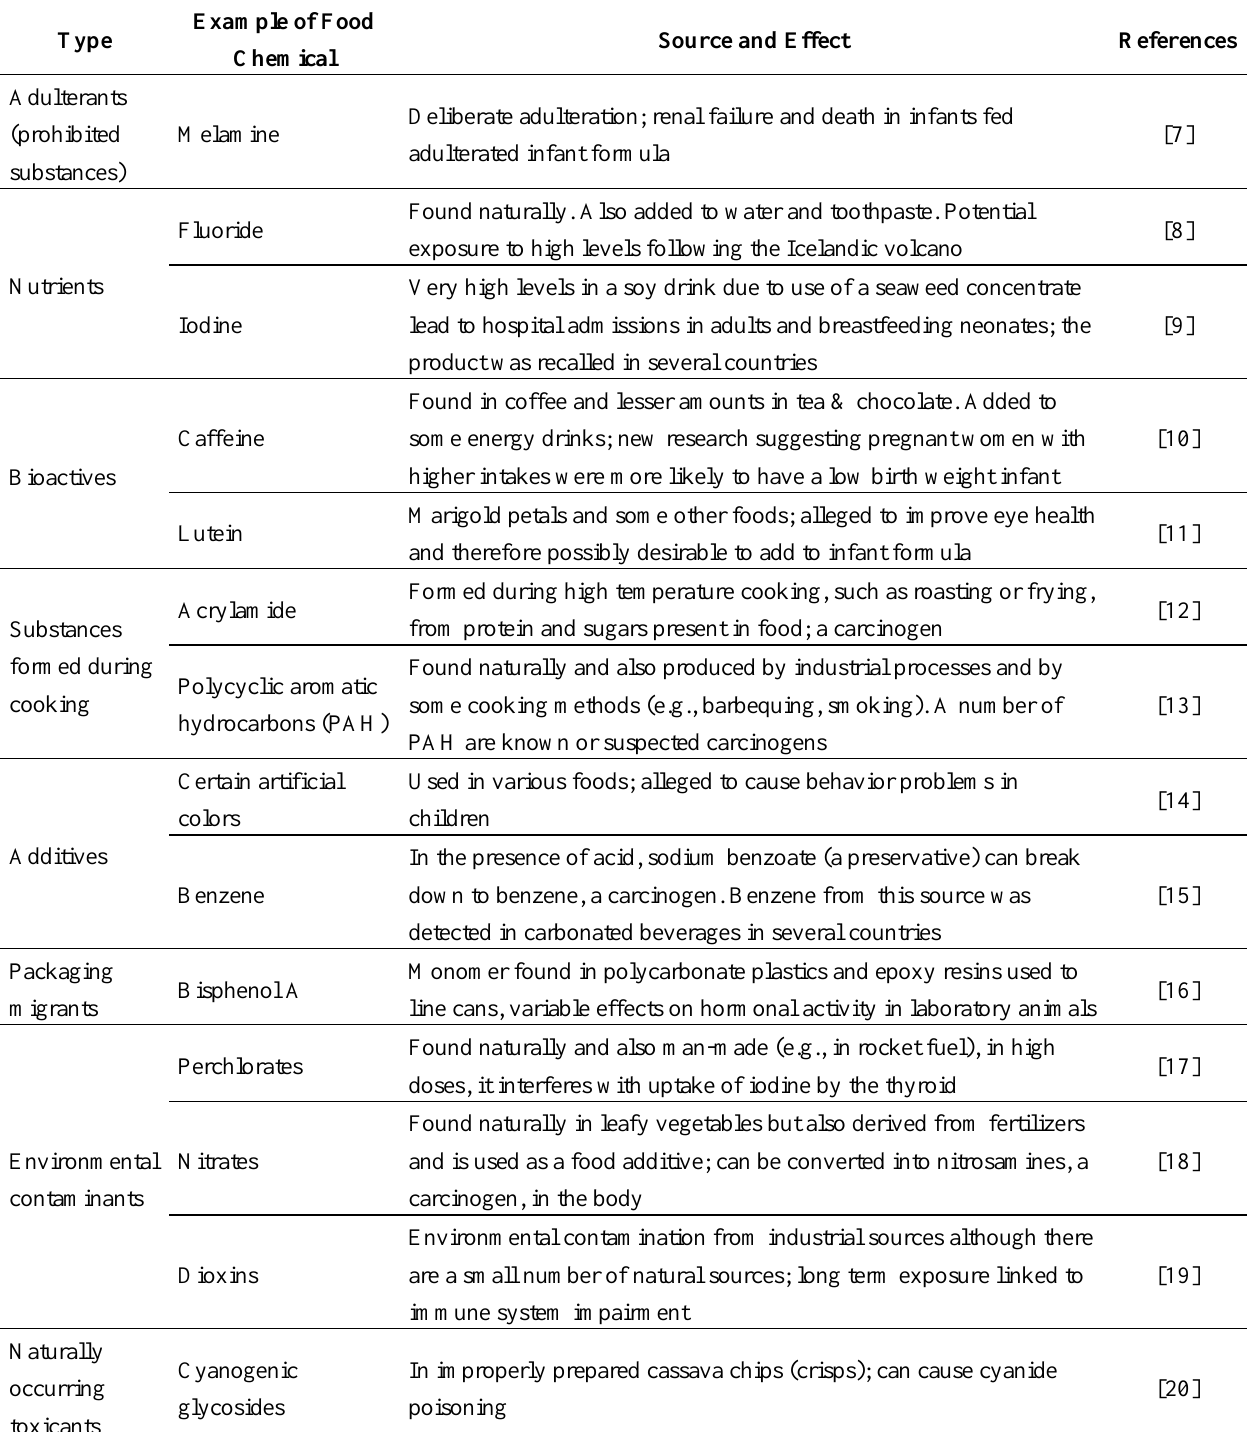
Table 1. Some food chemicals of recent international interest to food regulation